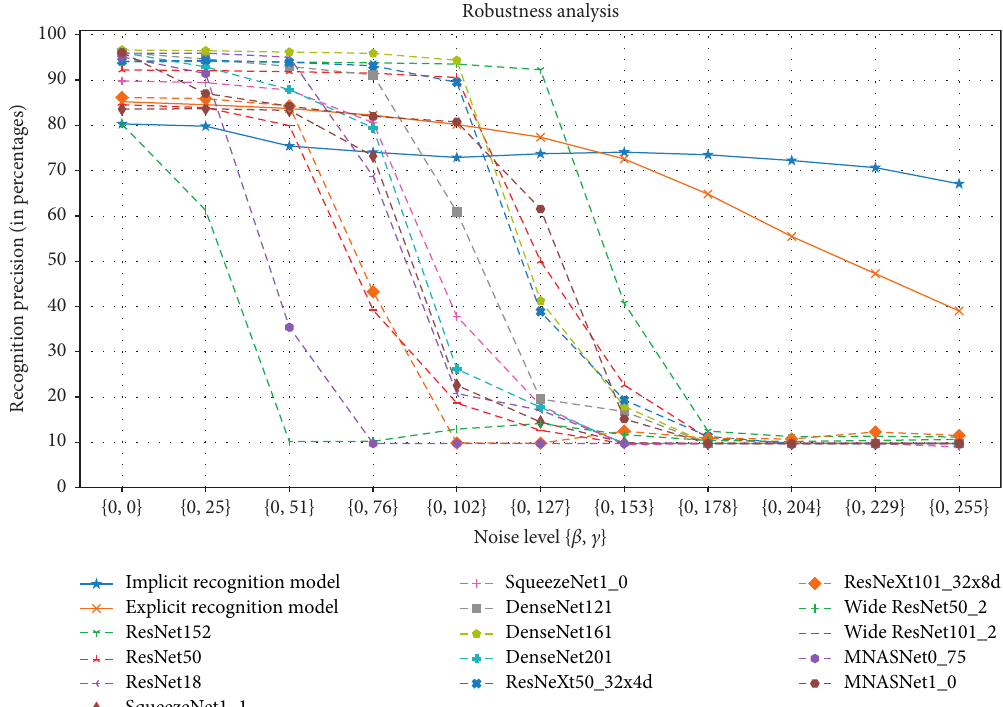
Figure 16: Recognition precision of Implicit Recognition Model, Explicit Recognition Model, ResNet, SqueezeNet, DenseNet, ResNeXt, Wide ResNet, and MNASNet at noise levels {0, 0}, {0, 25}, {0, 51}, {0, 76}, {0, 102}, {0, 127}, {0, 153}, {0, 178}, {0, 204}, {0, 229}, and {0, 255}.